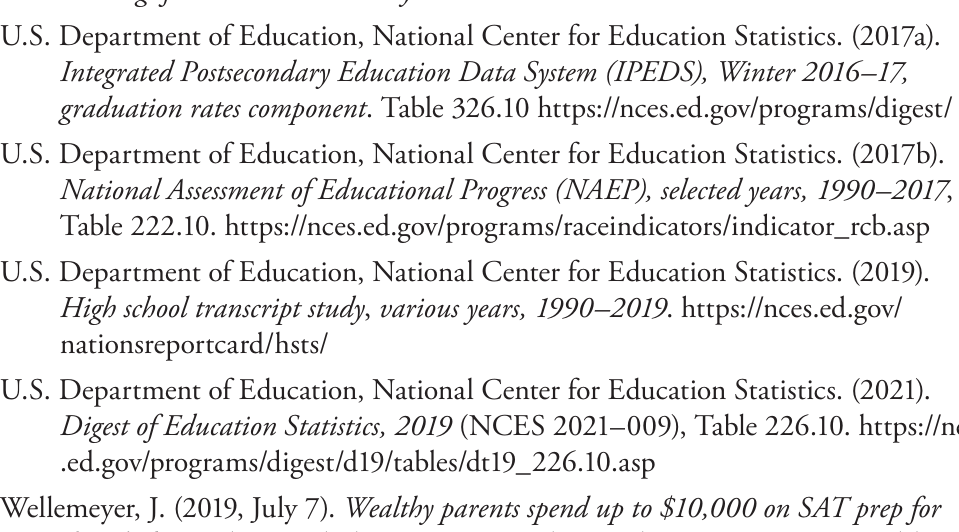
Table 222.10. https:// nces .ed .gov/ programs/ raceindicators/ indicator _rcb